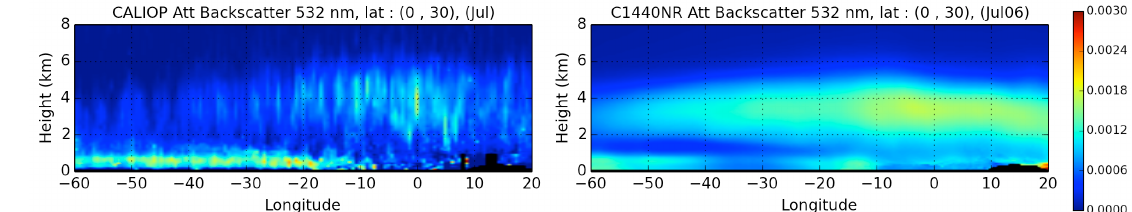
Figure 7: Vertical profiles of attenuated backscatter coecient only due to aerosols at 532 nm over the Figure 5. Vertical profiles of aerosol attenuated backscatter coefficient at 532 nm over the African dust African dust region (60°W – 20°E, 0°N – 30°N). On the left are time-averaged retrievals from CALIOP for region (60 ◦ W – 20 ◦ E, 0 ◦ N – 30 ◦ N). On the left are time-averaged retrievals from CALIOP for July July 2011. On the right are results from the Nature Run simulation but for July 2006. 2011. On the right is the G5NR simulation July